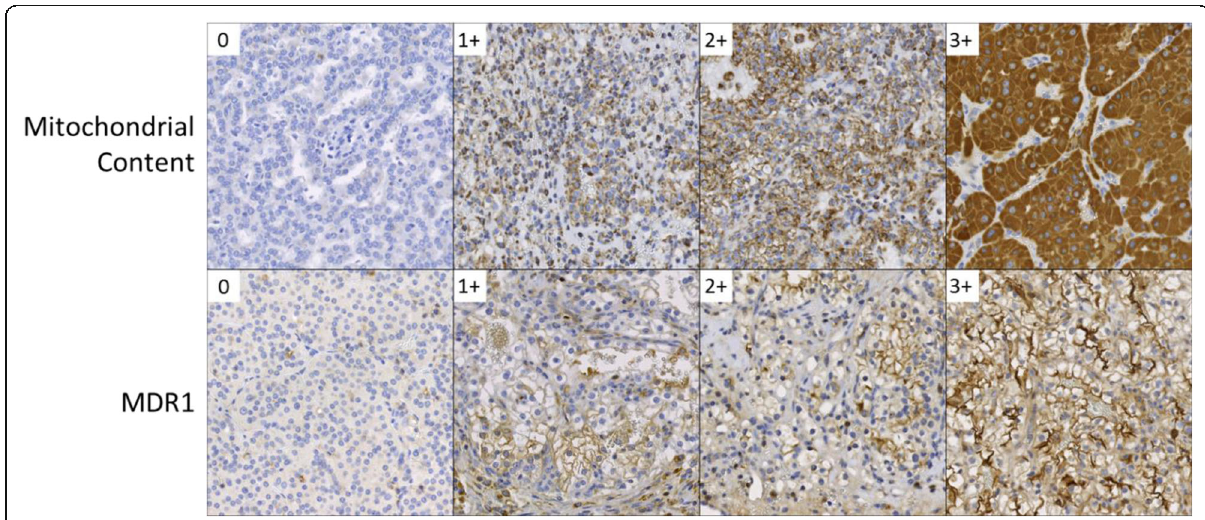
Fig. 2 Spectrum of immunohistochemical staining for mitochondrial content and MDR1. The numbers in the white inlays within each panel indicate the IHC score of each for each representative